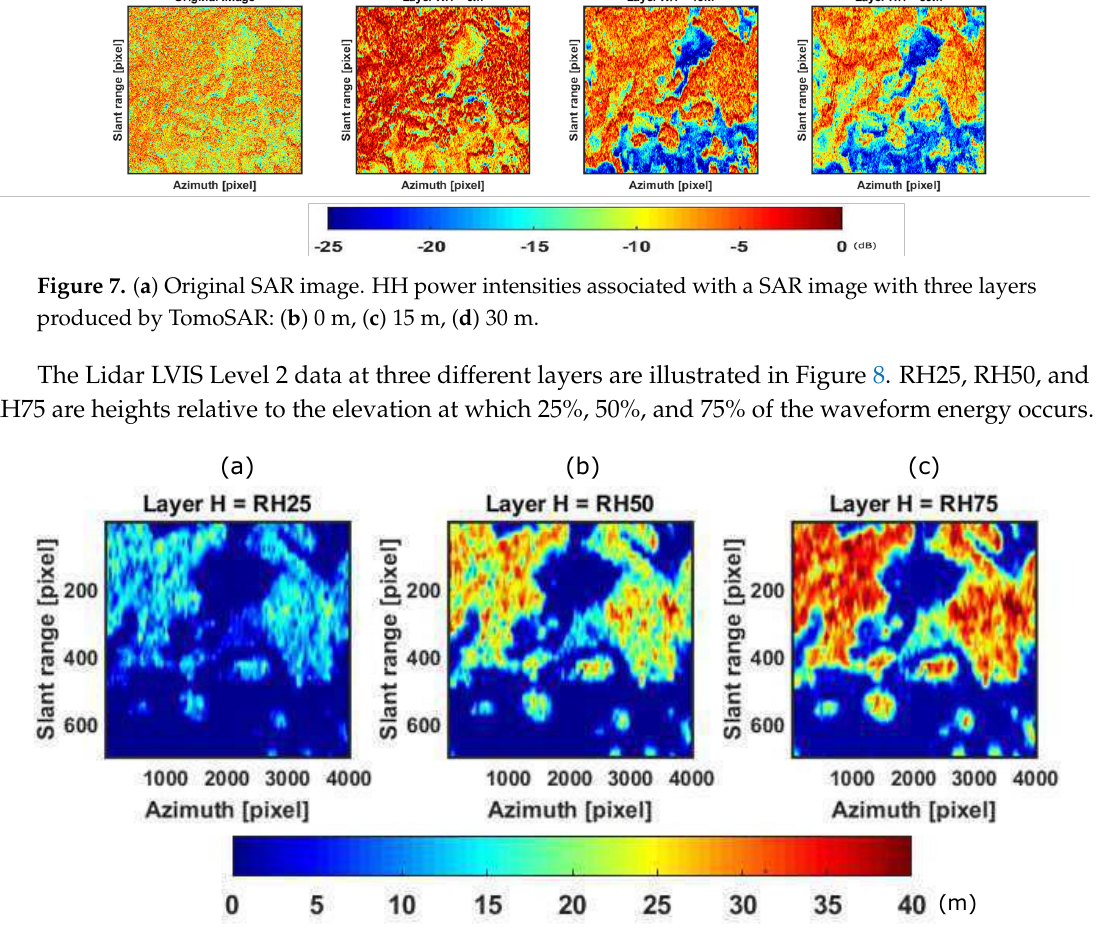
Figure 8. Lidar LVIS Level 2 different layers: ( a ) RH25, ( b ) RH50, and ( c ) RH75 corresponds to the Lidar LVIS layers. RH25% represents the elevation where 25% of the waveform energy occurs (ground layer). RH50% represents the elevation where 50% of waveform energy occurs, and RH75% represents the elevation where 75% of waveform energy